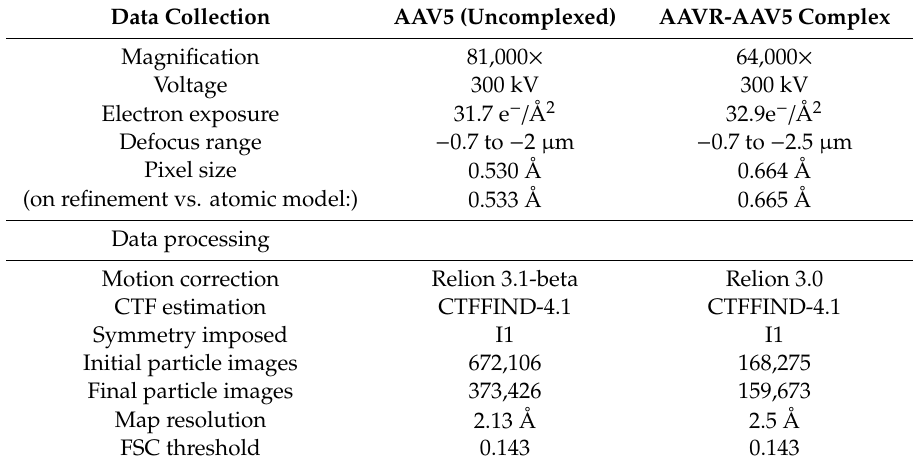
Table 1. Cryo-EM data collection and processing.